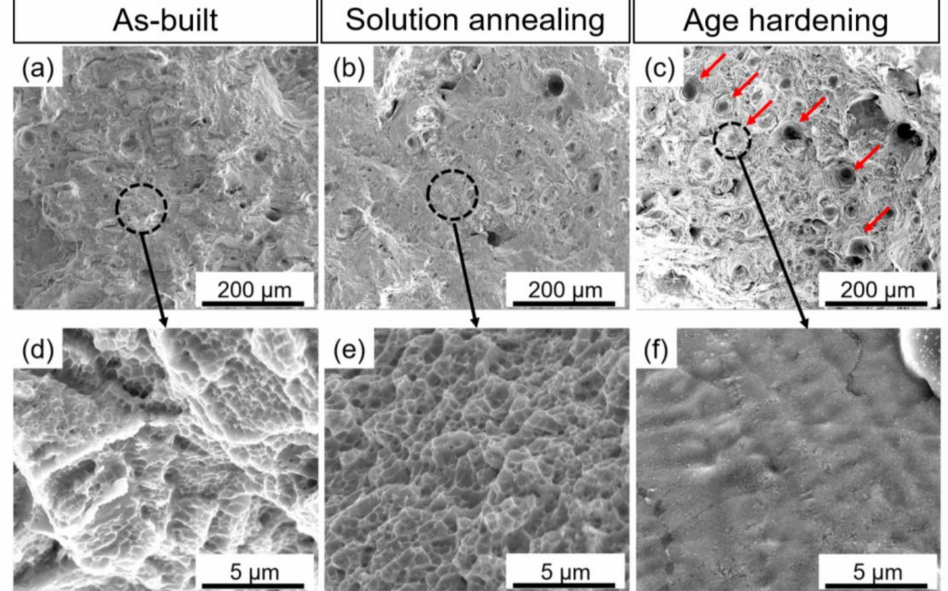
Figure 18. Fracture surfaces of micro-LPBF processed Inc718 samples after uniaxial tensile tests; ( a , d ) as-built sample, ( b , e ) solution annealed sample, ( c , f ) single-step age hardened sample at 720 ◦ C for 8 h